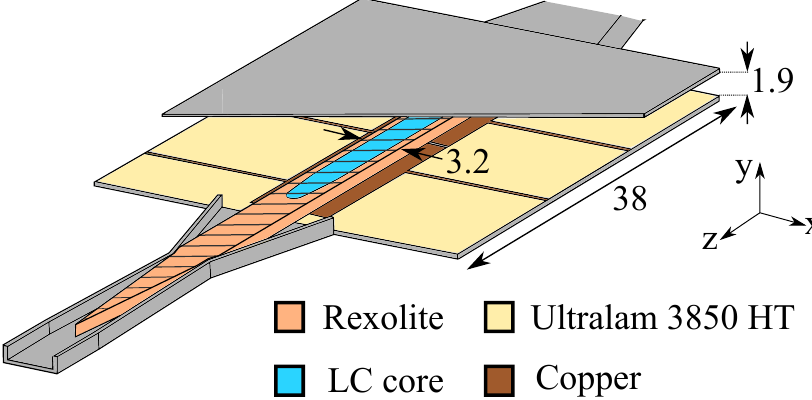
Figure 19. Cross section of the LC PPDW phase shifter with transition to WR15 waveguide, as presented in [24]. All dimensions are given in